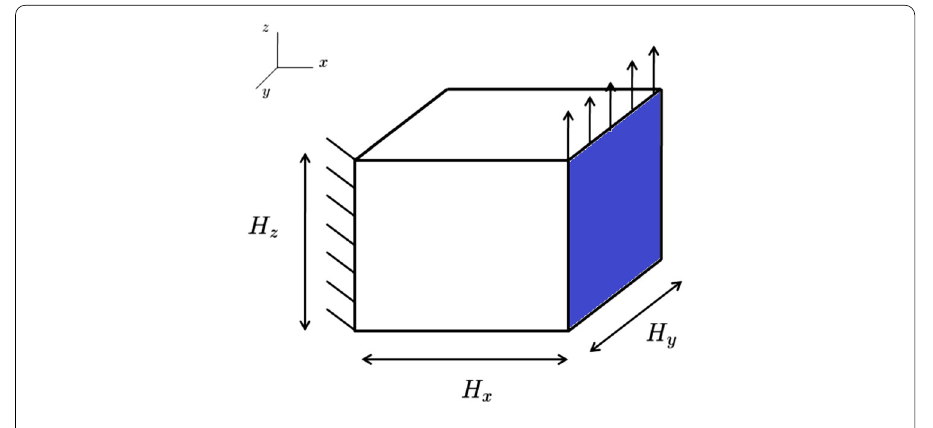
Fig. 1 The problem taken into consideration